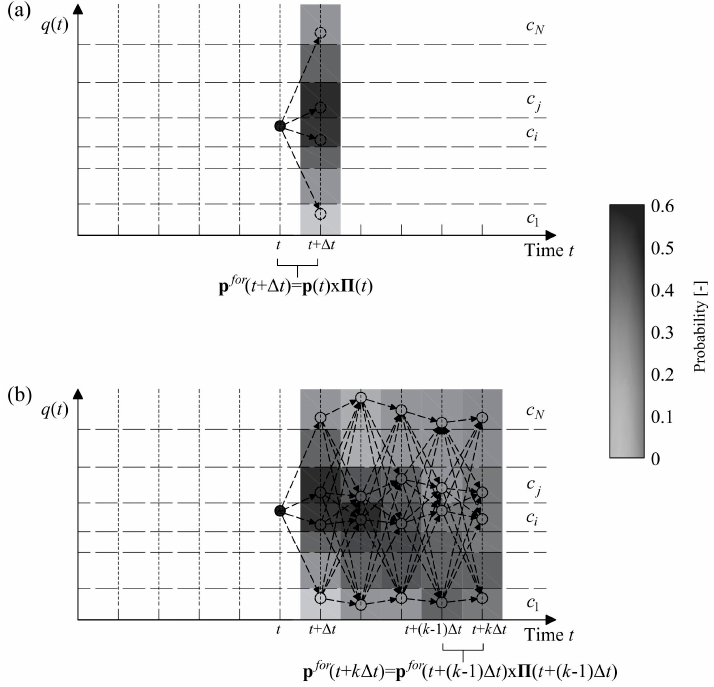
Figure 2. Estimated posterior probability vector p for ( a ) for one step ahead and ( b ) for k steps ahead, highlighted using a shade of grey for each class.